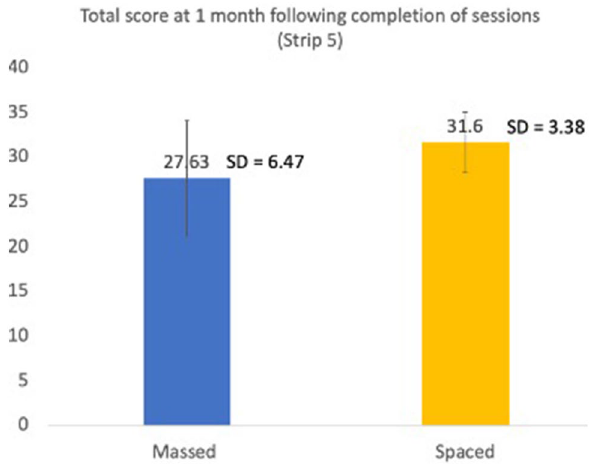
Figure 2. Primary outcome—total score at 1 month following completion of sessions (Strip 5).